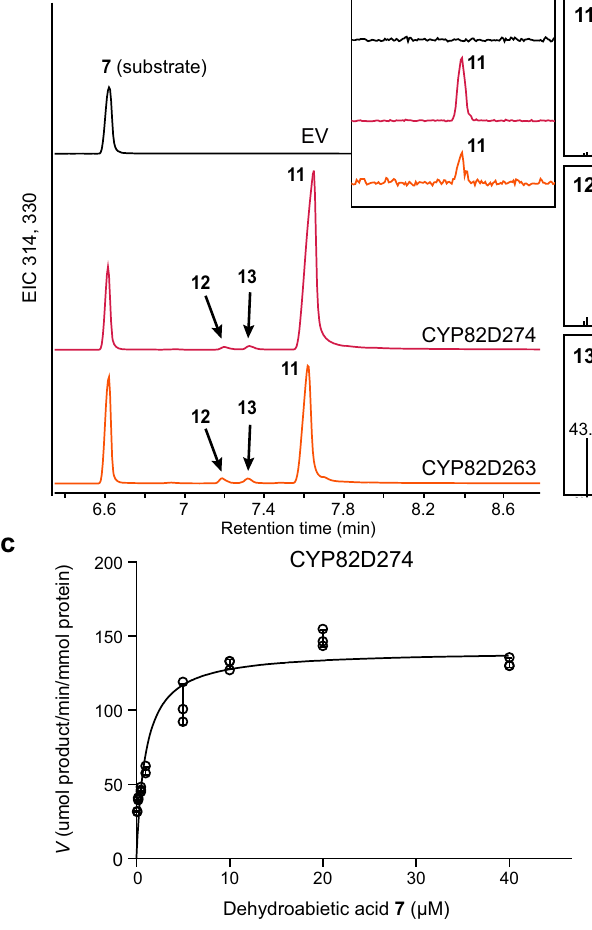
TheconcentrationofCYPswasestimatedbymeasuringthereducedCO-difference spectrum. Kinetic parameters were calculated by nonlinear regression analysis using the Michaelis ‒ Menten model. Data are presented as mean values±standard deviation SD from three biological independent replicates, and the black circles representtheindividualdatapoints.SourcedataareprovidedasaSourceData fi